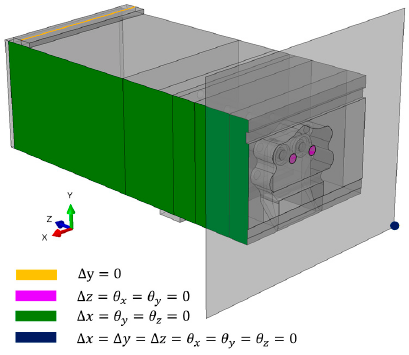
Figure 11. Model after assembly and boundary settings.